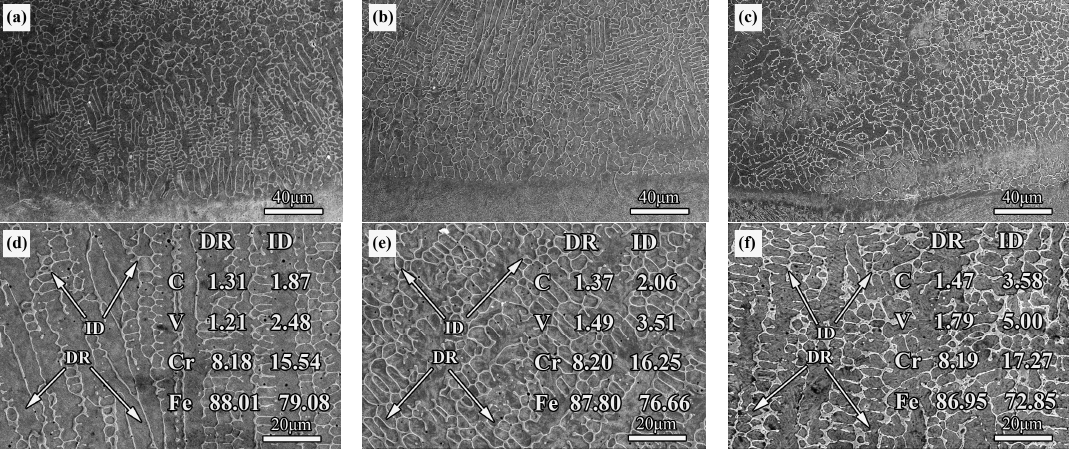
Figure 2. SEM images of the interface and the microstructures of the laser cladded Fe ‐ based coatings: ( a,d ) S1; ( b,e ) S2; ( c,f ) S3.